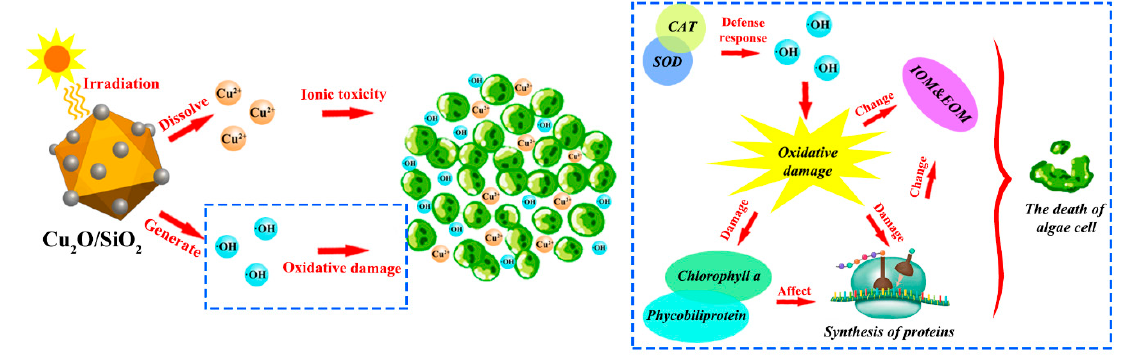
Figure 11. Mechanism of Cu 2 O/SiO 2 inhibiting algae growth.